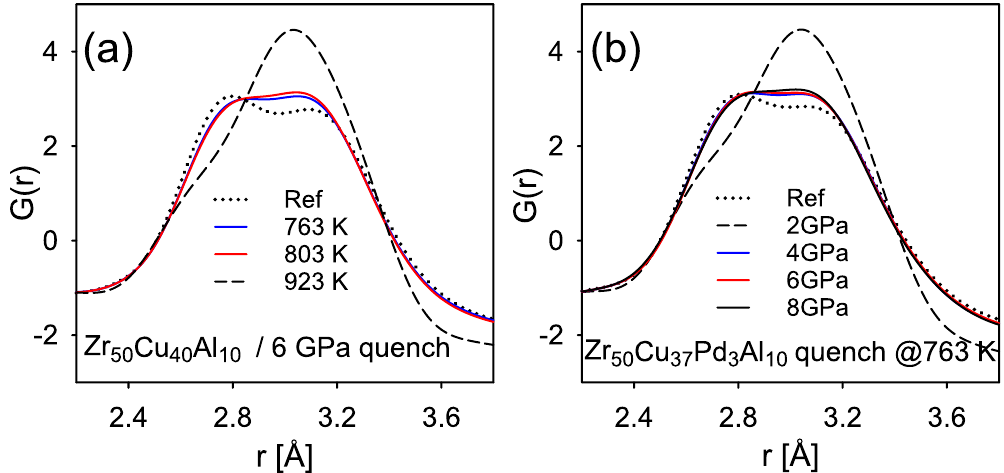
Figure 4. ( a , b ) Panel (a) shows the first PDF peak for Glass A quenched from the SCL under the same pressure 6 GPa from different temperatures and panel (b) first PDF peak for glass B quenched from the SCL from the same temperature 763 K but at various pressures.